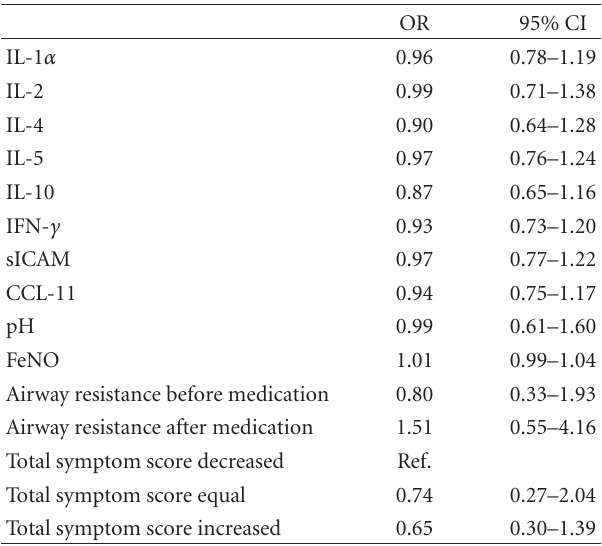
Table 3: Changes induced by inhaled corticosteroids related to an asthma